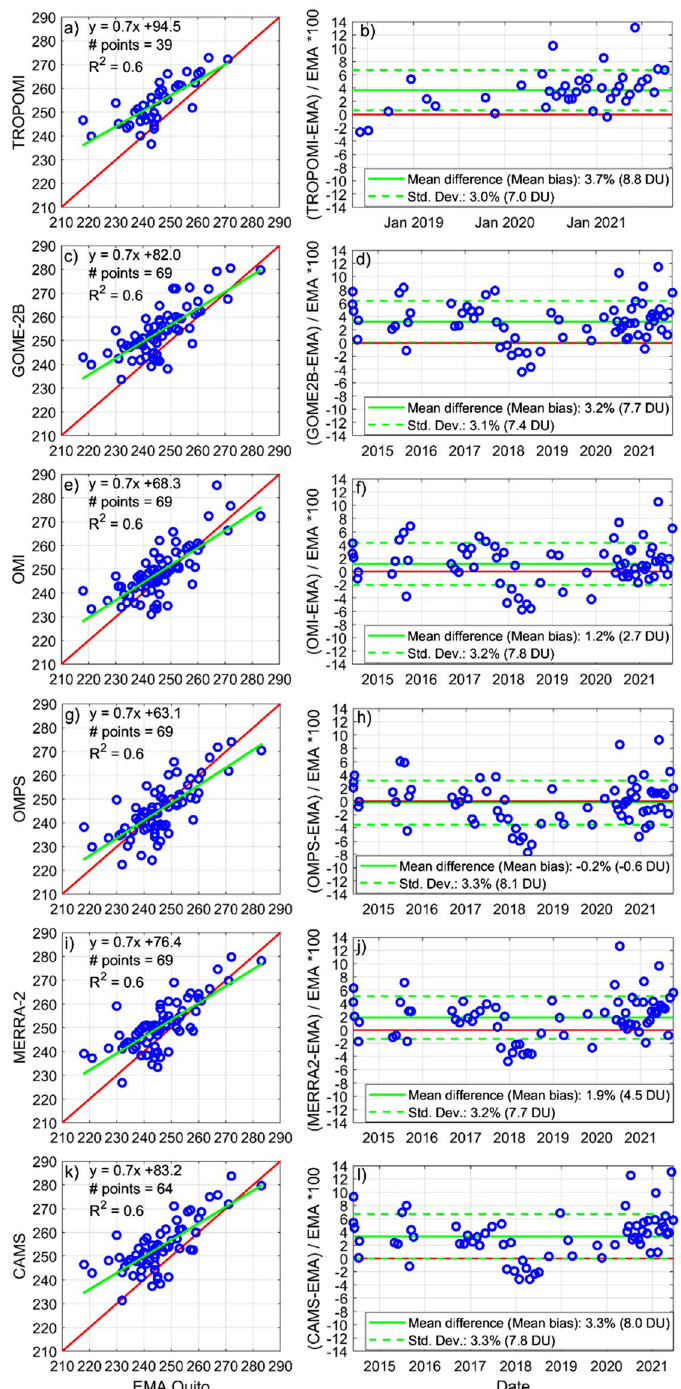
Figure 2. Total column ozone (TCO) comparisons between spaceborne observations and ozonesonde measurements taken in Quito, Ecuador (EMA USFQ). 1:1 comparisons and linear regressions are depicted in left panels, while mean percentage differences (or mean biases) are quantified in right